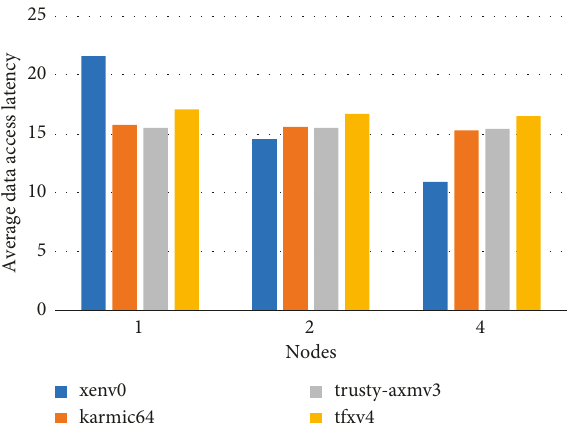
Figure 14: Evaluation of the L2-cache miss rate in the COTSon framework when using the matrix multiplication benchmark by varying cache sizes, number of nodes of the distributed system, and different Linux distribution (“xenv0” 9.10, “trusty-axmv3” Ubuntu 14.04, and “tfxv4” Ubuntu 10.10). The Linux distribution “xenv0” shows the lowest L2 miss rate compared (cid:31) (cid:31) to the other Linux distributions for all the presented configurations.